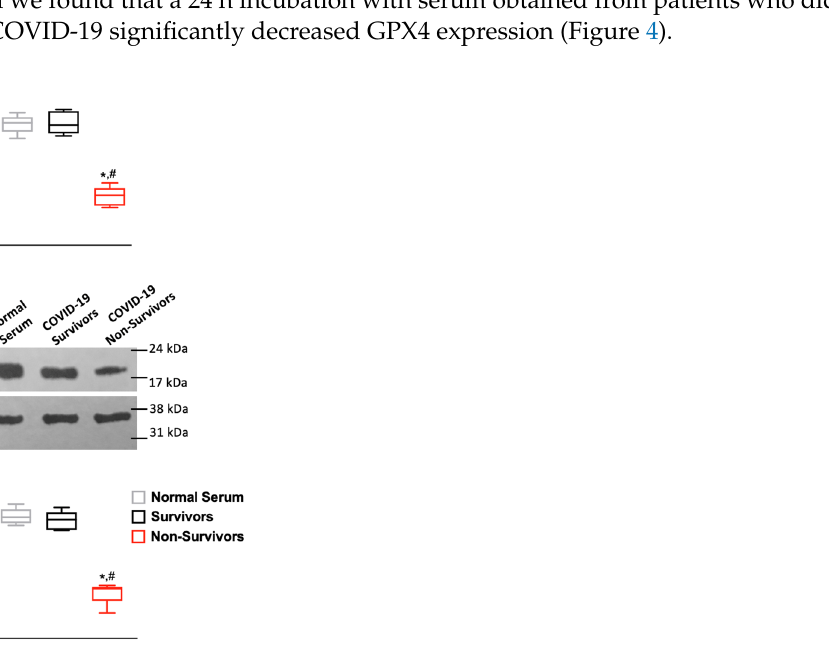
Figure 4. GPX4 expression in human endothelial cells is reduced by serum from patients who did not survive COVID-19. GPX4 levels were measured by RT-qPCR ( A ) and by immunoblot ( B ) in HUVECs, normalizing to glyceraldehyde 3-phosphate dehydrogenase (GAPDH); panel B shows representative blots from triplicate experiments (top) and their quantification (bottom). All experiments were performed at least in triplicate; the box-and-whiskers graphs show the median and the 5th–95th percentiles; *: p < 0.01 vs. Normal Serum, #: p < 0.01 vs. COVID-19 Survivors. Sequences of oligonucleotide primers are reported in Table 1.